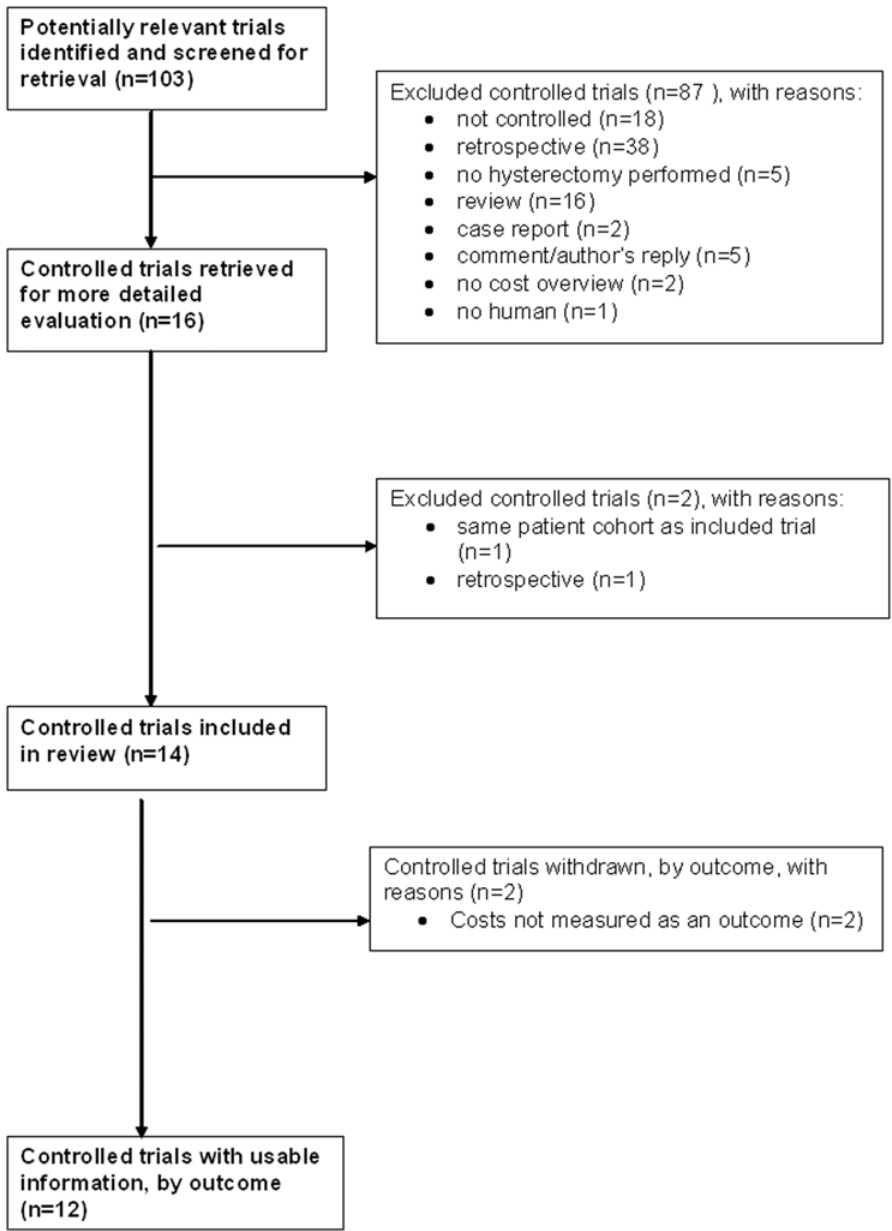
Figure 1. Flowchart of included studies.